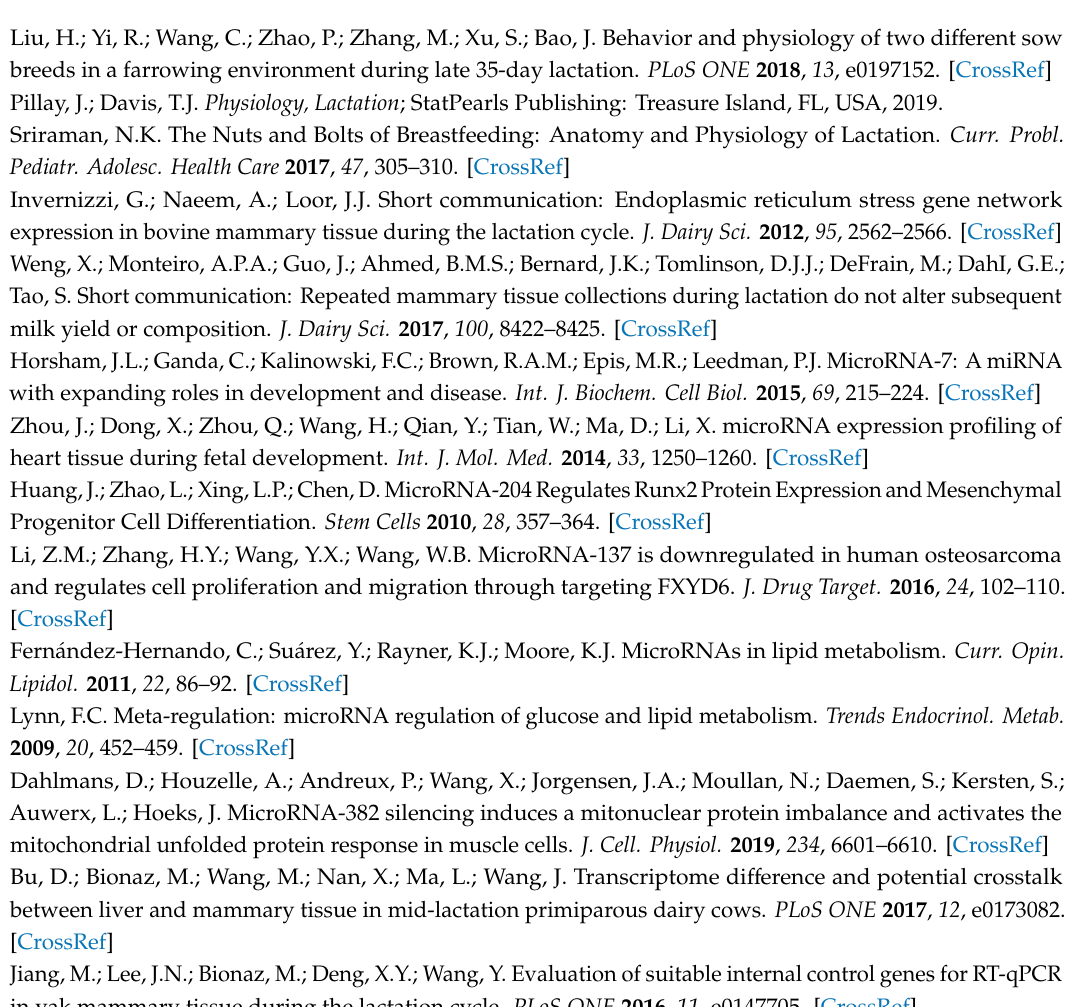
Supplementary Materials: The following are available online at www.mdpi.com/xxx/s1. Table S1: The sequences used for miR-183. Table S2: The PCR products sequencing data of nine reference genes. Table S3: The sequences used for IRS1-siRNA. Table S4: The sequences used for construction target gene 3'-UTR luciferase reporter vector.